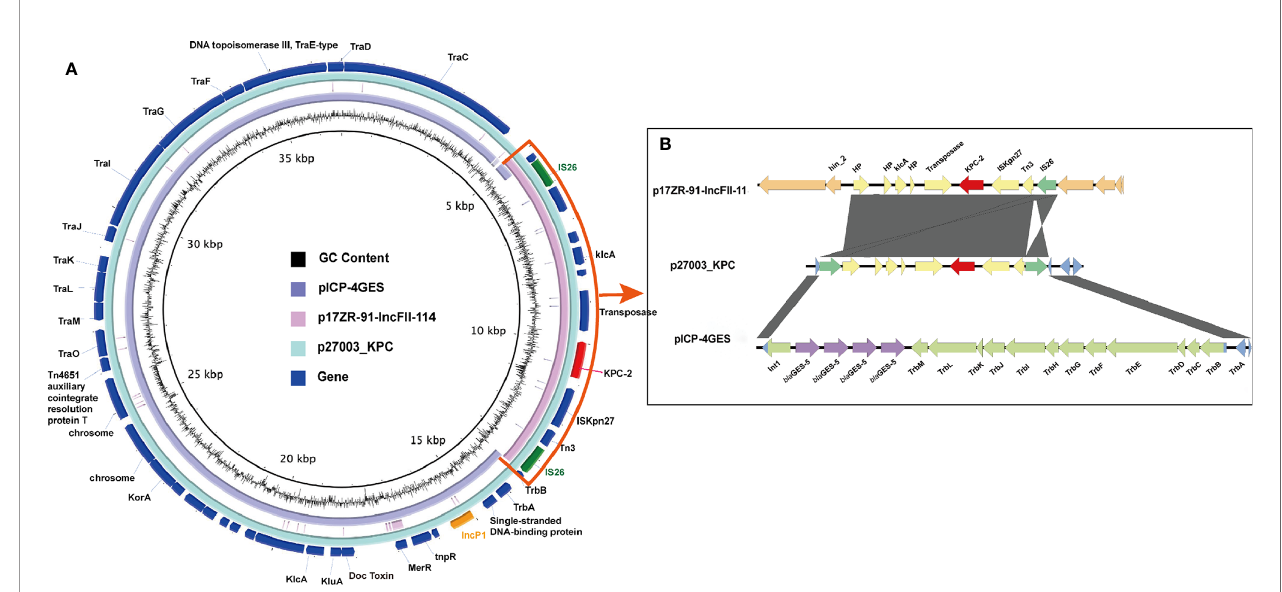
FIGURE 1 | Similarity of the genetic structure of p27003_KPC with that of two other plasmids. (A) Alignments of similar genes on plasmids are shown as concentric parts. The outer ring shows the ORFs on p27003_KPC. bla KPC-2 is colored red, while IncP1 and IS 26 are colored orange and green, respectively. (B) The hybrid parts are highlighted and described in the box on the right. ORFs are illustrated as arrows. Shading areas indicate the high homology regions ( ≥ 95% identity) with the yellow or blue CDS. Orange and green boxes represent the backbone CDS on p17ZR-91-IncFII-11 and pICP-4GES,